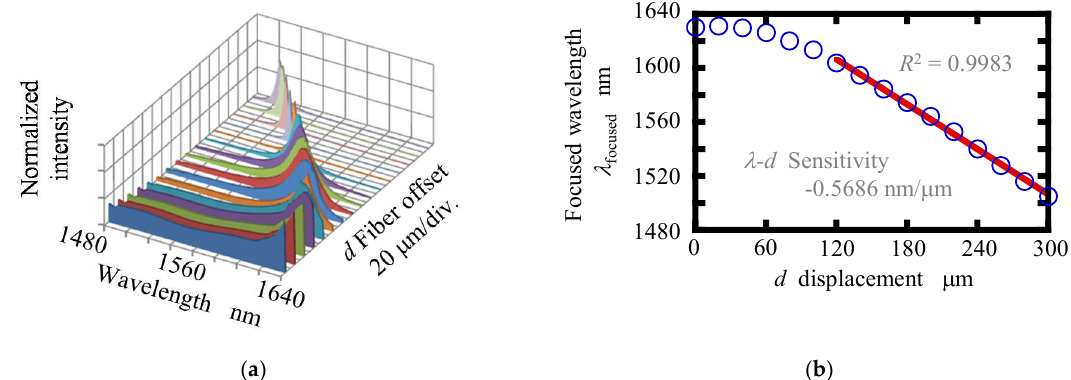
Figure 9. Relationship between the defocus d and the focused wavelength λ focused : ( a ) The relationship between d and the obtained normalized axial responses I n ; ( b ) The relationship between d and the focused wavelength λ focused extracted from the normalized axial responses shown in Figure 9a.